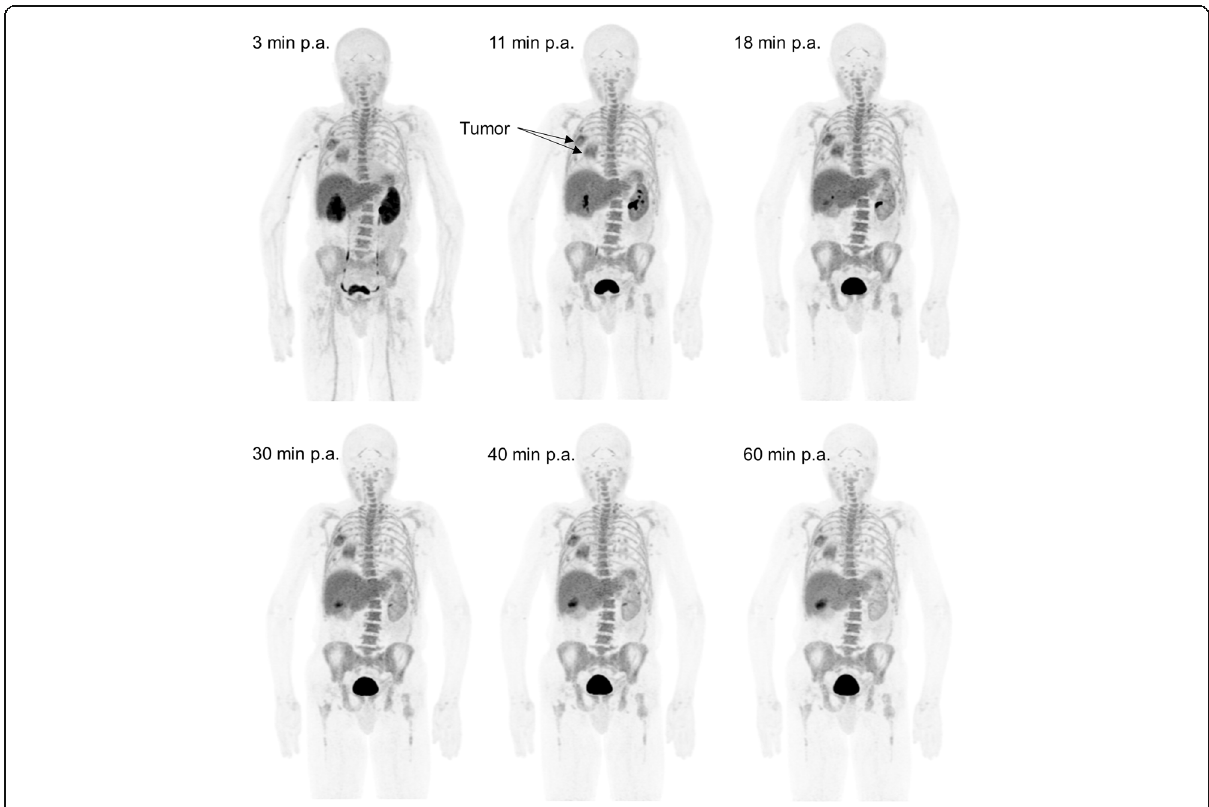
Fig. 1 Example of maximum intensity projections 3, 11, 18, 30, 40, and 60 min post-tracer administration (p.a) showing in-patient 18 F-Azafol activity distribution